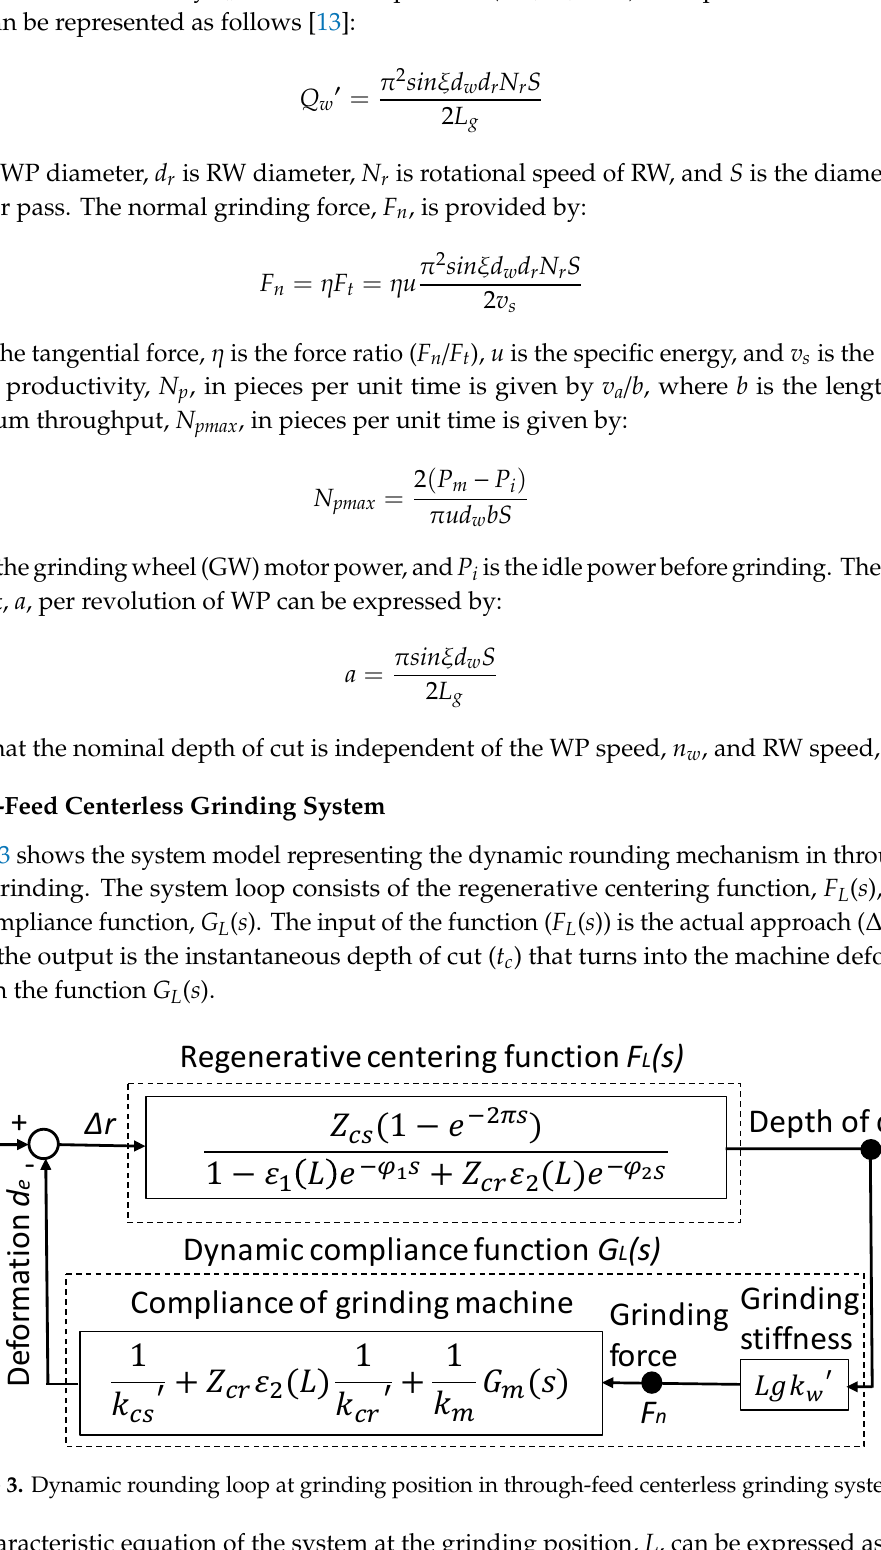
Figure 2. Regulating wheel (RW) profile and center ‐ height angle. ( a ) RW diameter; ( b ) RW profile; ( c ) Center ‐ height angle γ .